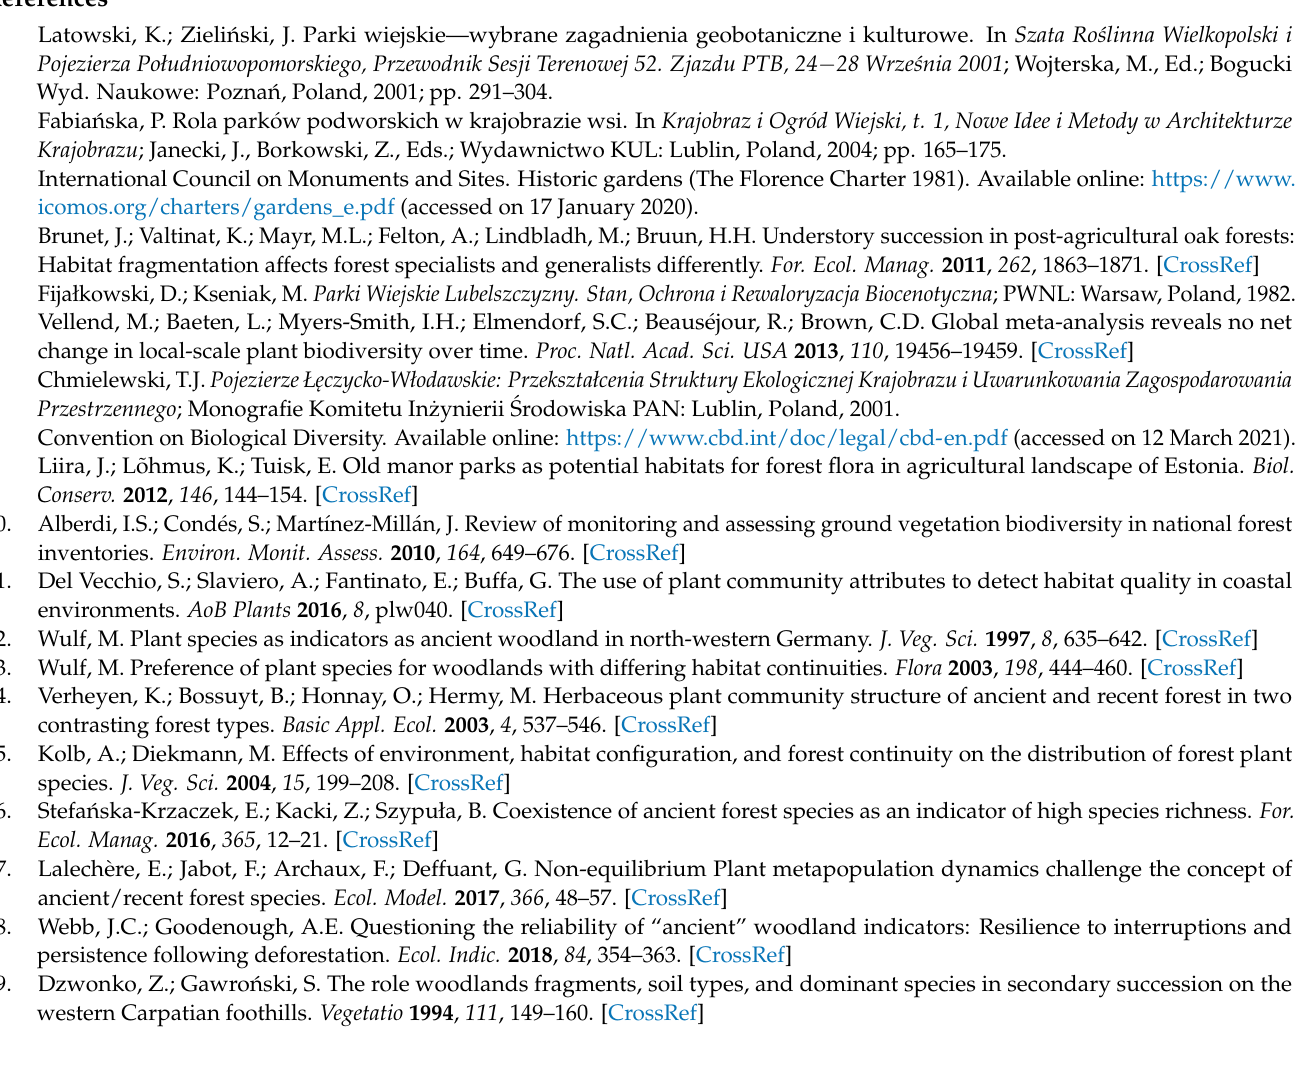
Table S7: Data of the phytosociological records (Braun-Blanquet) in manor parks not adjacent to forests (records